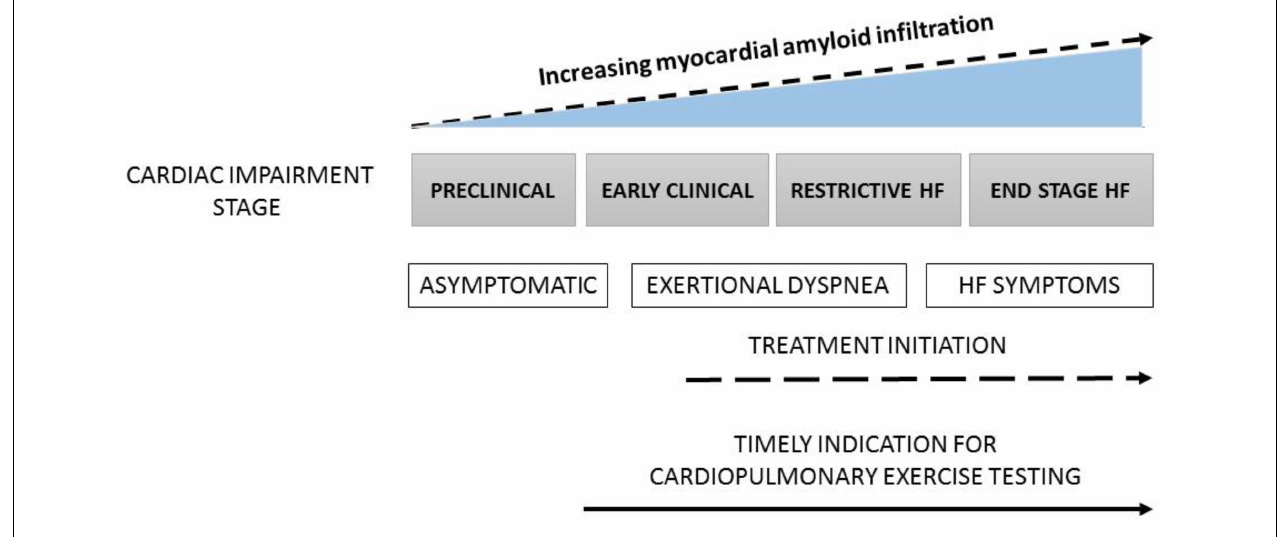
FIGURE 1 | The progression of CA from asymptomatic stage to end stage heart failure (HF) and timing for the use of cardiopulmonary exercise testing